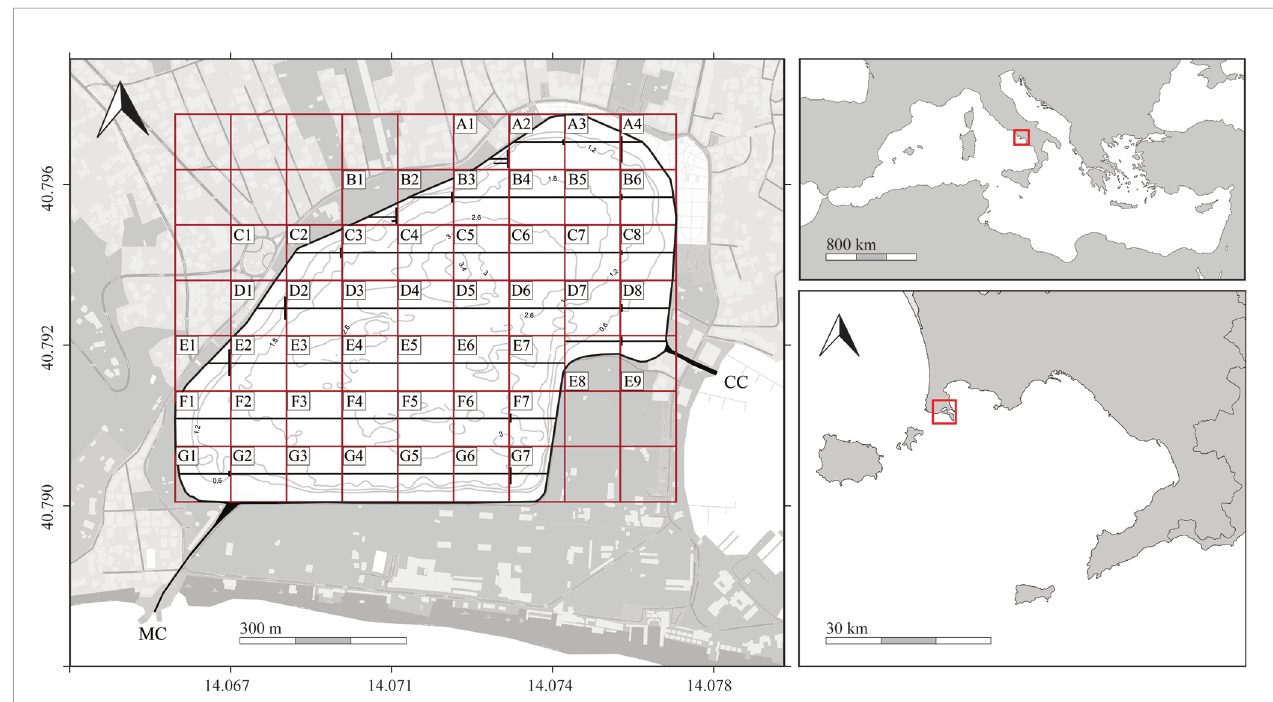
FIGURE 1 | The Miseno Lake and its position (red square) in the Mediterranean Sea (top right) and in the Gulf of Naples (bottom right). Left image highlighting sampling grid (red squares), longitudinal transects (black lines), dock wall perimeter, channels (CC, Casevecchie channel; MC, Miliscola channel), and simpli fi ed bathymetry (for a detailed bathymetric map see Supplementary Figure 1